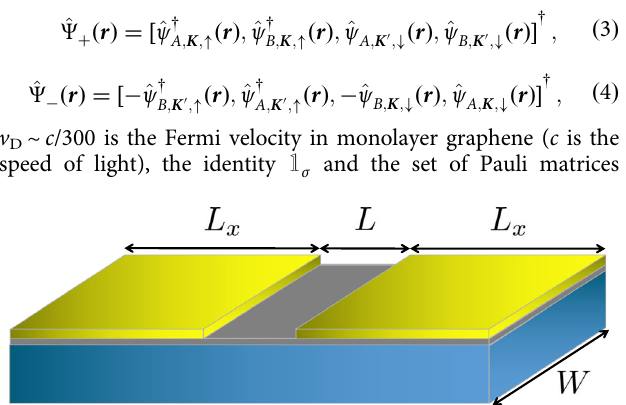
Fig. 1 Schematic of the device. From bottom to top there are a substrate (blue), a monolayer graphene (gray) and two superconducting electrodes (yellow). The uncovered gray region represents the stripe in normal phase and yellow sides are the regions covered by superconductors. Here, L represents the junction channel, L x is the lateral size of each superconducting electrode, and W is the length of the device along the invariant